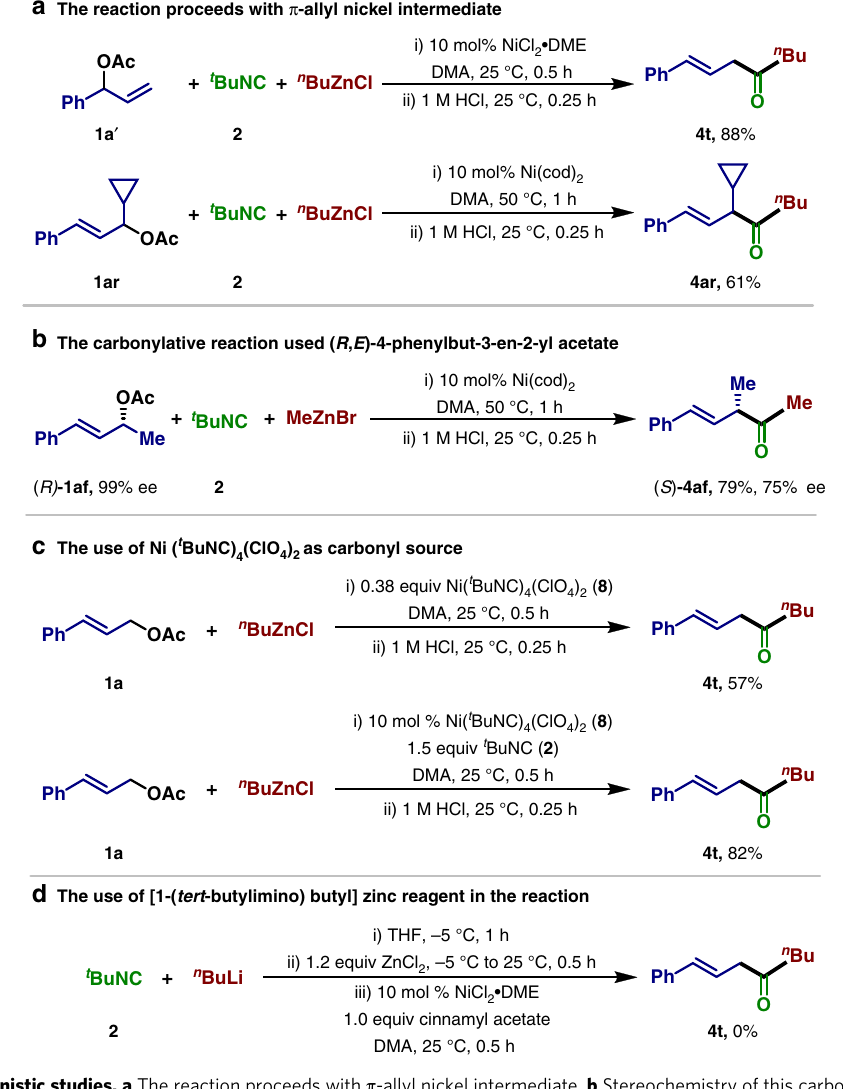
Fig. 6 Preliminary mechanistic studies. a The reaction proceeds with π -allyl nickel intermediate. b Stereochemistry of this carbonylative coupling reaction. c The use of Ni( t BuNC) 4 (ClO 4 ) 2 as carbonyl source. d The use of [1-( tert -butylimino) butyl] zinc reagent in the reaction.